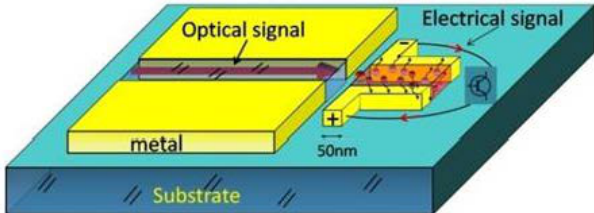
Figure 13: Schematics of a plasmonic waveguide dipole antenna photodetector, consisting of two L-shaped metallic nanorods, which are used to form a nanoantenna, a nanocavity as well as a half- wavelength waveguide to eflciently couple the electromagnetic fields from the plasmonic waveguide to the detector.